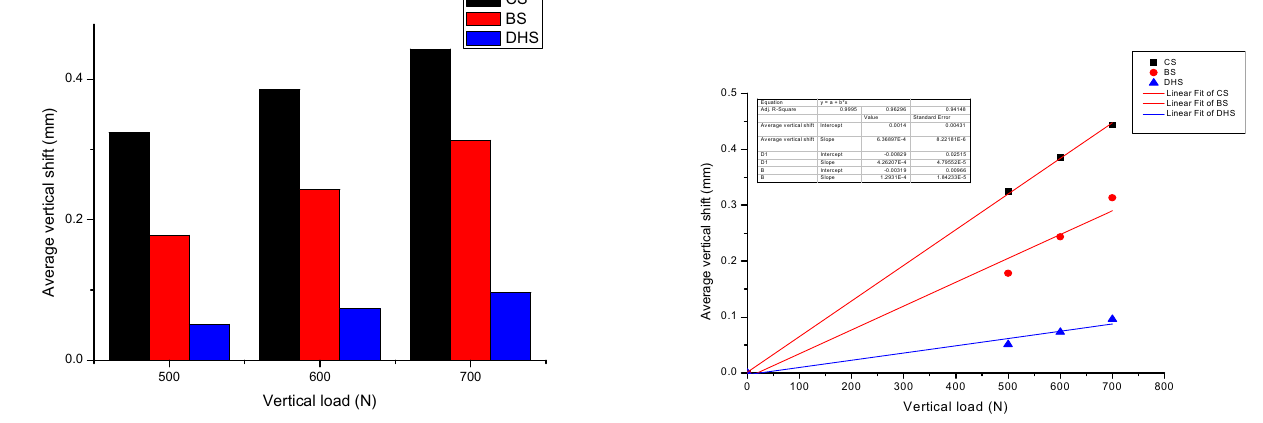
Figure 10. Left, vertical displacement under the load of 400, 600 and 800 N; right: linear fitting of average vertical shift and vertical load.